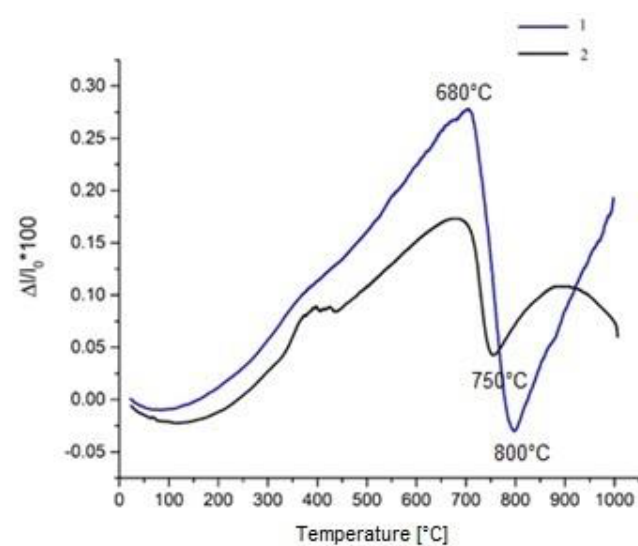
Figure12. Dilatometricheatingcurveofthesteelofthetoothandcarbidecoating: 1—toothsteelmaterial, 2—carbide coating.